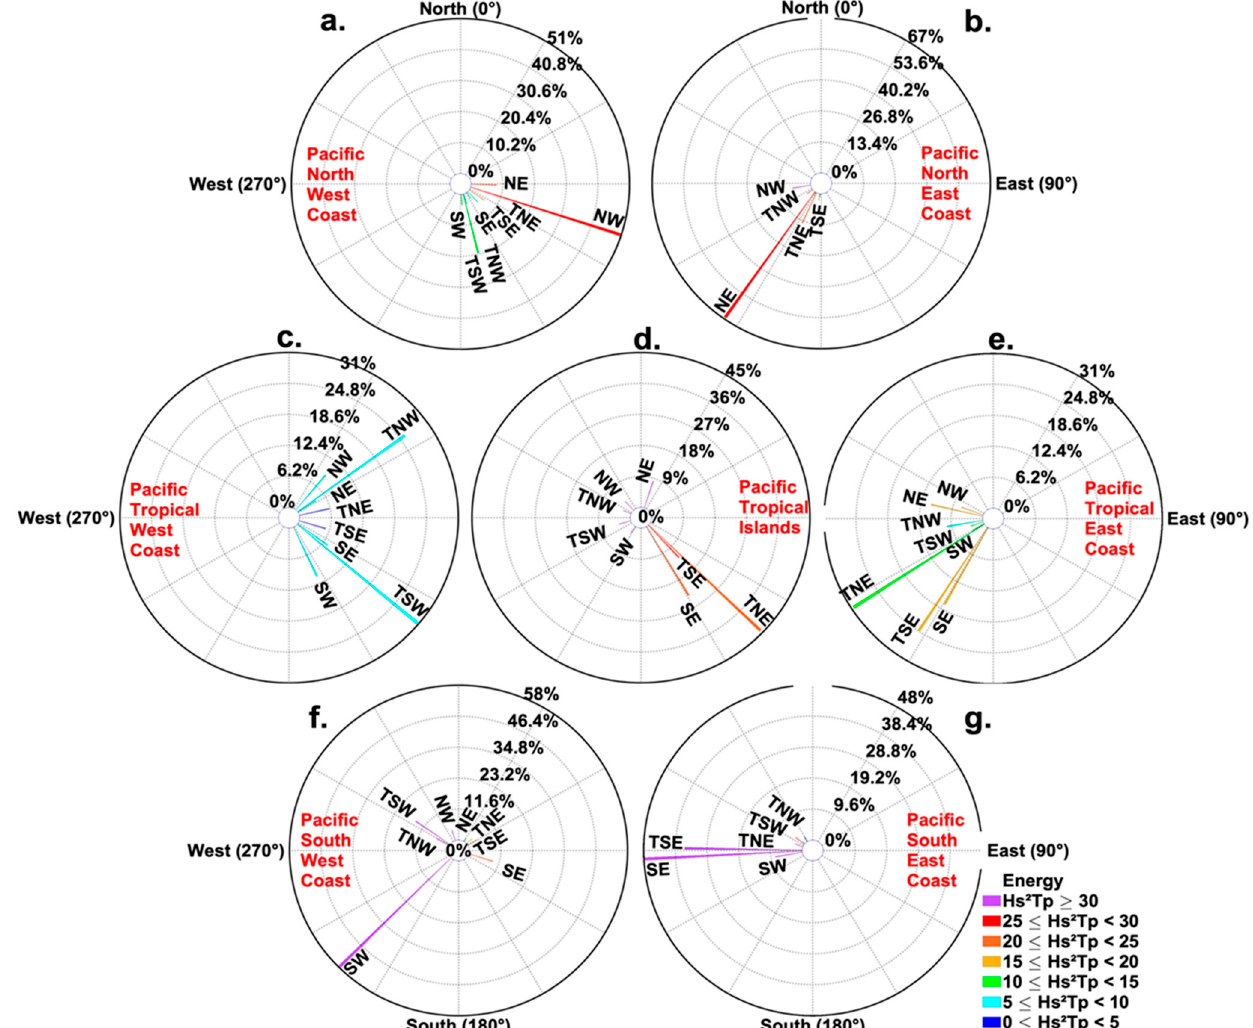
Figure 4. Mean characteristics (% of occurrence, direction of incidence and energy in m 2 s) of extreme wave events detected in each coastal region delineated by the colored dots in Figure 1b, i.e., the Pacific North-West coast ( a ), North-East coast ( b ), Tropical West coast ( c ), Tropical Islands ( d ), Tropical East coast ( e ), South-West coast ( f ), and South-East coast ( g ), according to their open-ocean origin (Pacific North-West (NW), North-East (NE), Tropical North-West (TNW), Tropical North-East (TNE), Tropical South-West (TSW), Tropical South-East (TSE), South-West (SW), and South-East (SE)).